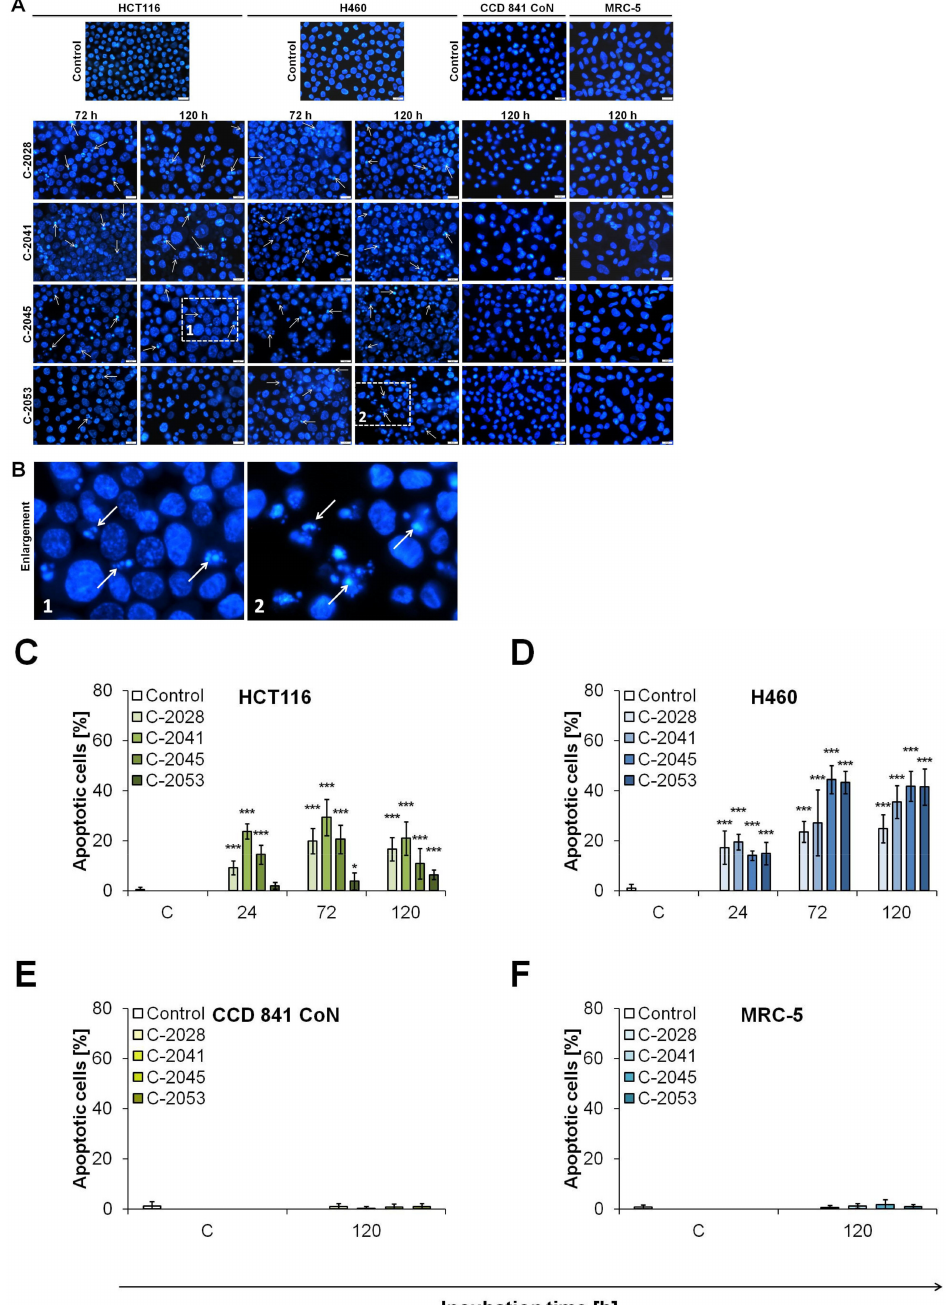
Figure 6. Morphological changes of nuclei of cancer and normal cells treated with UAs. ( A ) Pictures (representative of three independent experiments) present changes in nuclear morphology of HCT116, H460, CCD 841 CoN and MRC-5 cells treated with 0.04, 0.05, 0.4 and 0.2 µ M of C-2028, C-2041, C-2045 and C-2053 compounds. Cells were stained with Hoechst 33342 (1 mg/mL) and visualized under fluorescent microscope (400 × magnification). Arrows point at the cells with changes in the nuclei characteristic of apoptosis (condensed, intensely stained, fragmented chromatin). White scale bars presented on images correspond to 20 µ m ( B ) Enlarged fragments of pictures with indicated changes characteristic of apoptosis. ( C – F ) Bar graphs showing quantified data, expressed as the percentages of apoptotic cells established for HCT116 ( C ), H460 ( D ), CCD 841 CoN ( E ), and MRC-5 ( F ) cells. Significantly different from the control at: * p < 0.05; ** p < 0.01; *** p < 0.001; ( n ≥